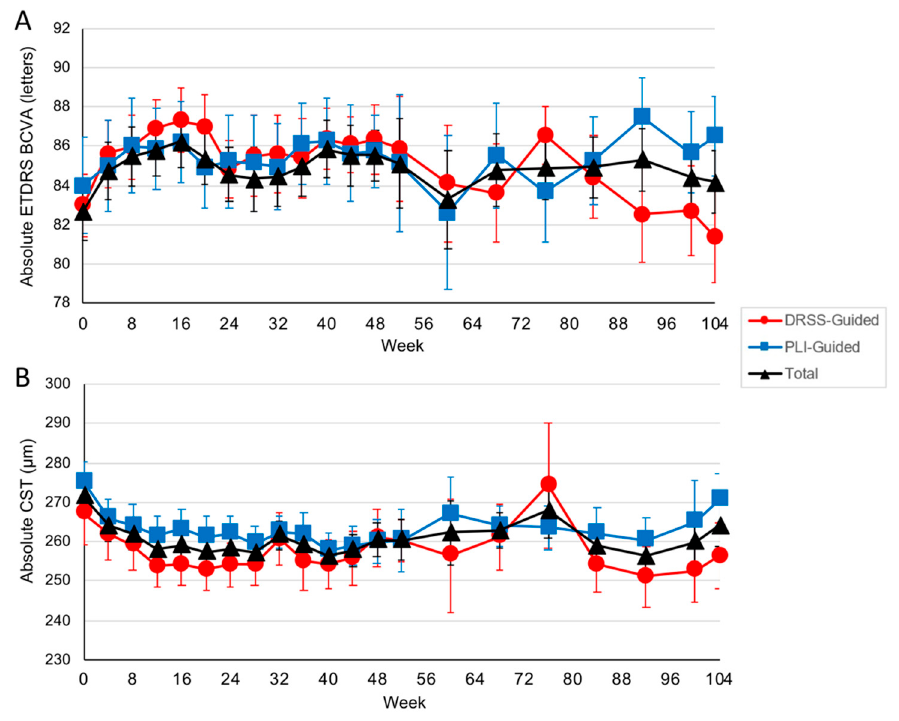
Figure 6. Visual and anatomic changes through week 104. ( A ) Mean absolute Early Treatment Diabetic Retinopathy Study (ETDRS) best-corrected visual acuity (BCVA) letters through week 104. ( B ) Mean absolute central subfield thickness (CST) through week 104. All error bars represent standard errors.